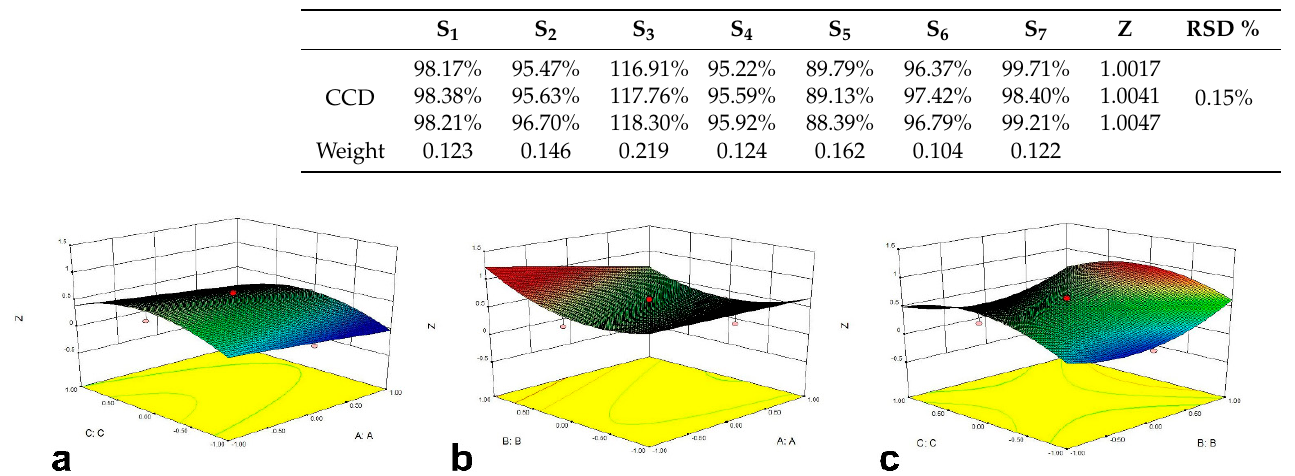
Figure 2. The effect of cross-interaction among pH value (X 1 ), extraction solvent concentration (X 2 ) and ethanol volume fraction (X 3 ) on Z value. ( a ) response surface plot of effects of the interaction between pH value and ethanol volume fraction on Z value, ( b ) response surface plot of effects of the interaction between pH value and extraction solvent concentration on Z value, ( c ) response surface plot of effects of the interaction between extraction solvent concentration and ethanol volume fraction on Z value.